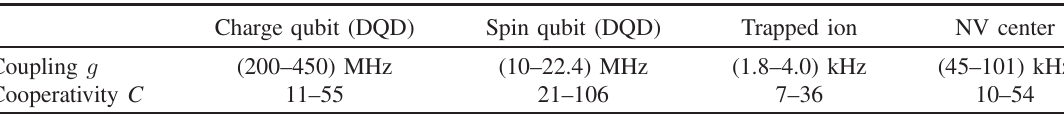
TABLE I. Estimates for single-phonon coupling strength g and cooperativity C . We use A ¼ ð 1 – 5 Þ μ m × 40 λ T ¼ 20 mK [17], (conservative) quality factors of Q ¼ ð 1 ; 1 ; 3 ; 1 Þ × 10 3 , and frequencies of ω 10 − 3 ; 3 Þ GHz for the four systems listed. For the spin qubit T ⋆ g C is given for d ¼ 150 μ m due to the prolonged dephasing time farther away from the surface ( C ion ð ion Þ improves with increasing d , even though g Further details are given in the